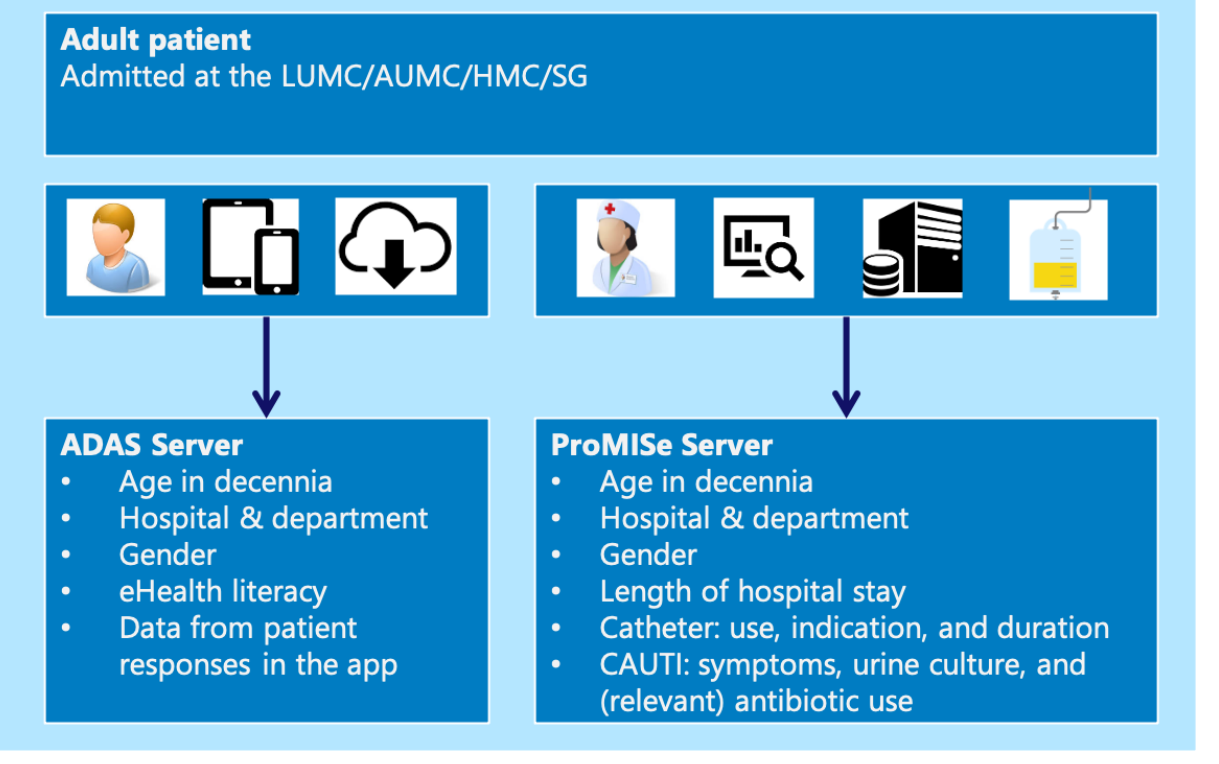
Figure 3. Data collection and secure storage at the LUMC on ADAS and ProMISe servers. CAUTI: catheter-associated urinary tract infection,